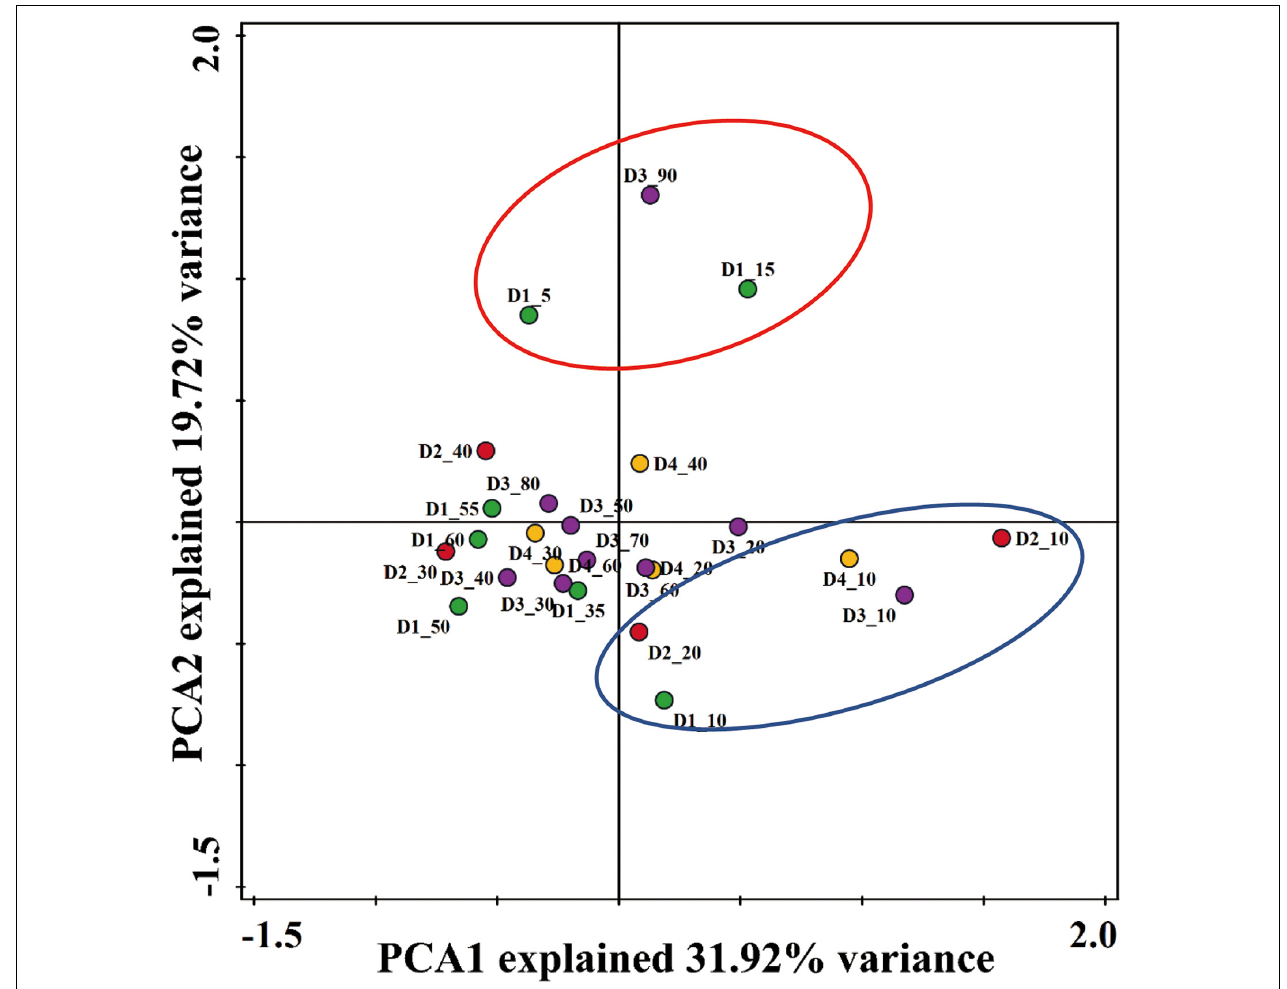
FIGURE 4 | Principal component analysis (PCA) of Nitrospira nxrB gene sequences retrieved from sediments of the DYB (STE). Horizontal and vertical axes represent the first two dimensions, axis 1 and axis 2, respectively.